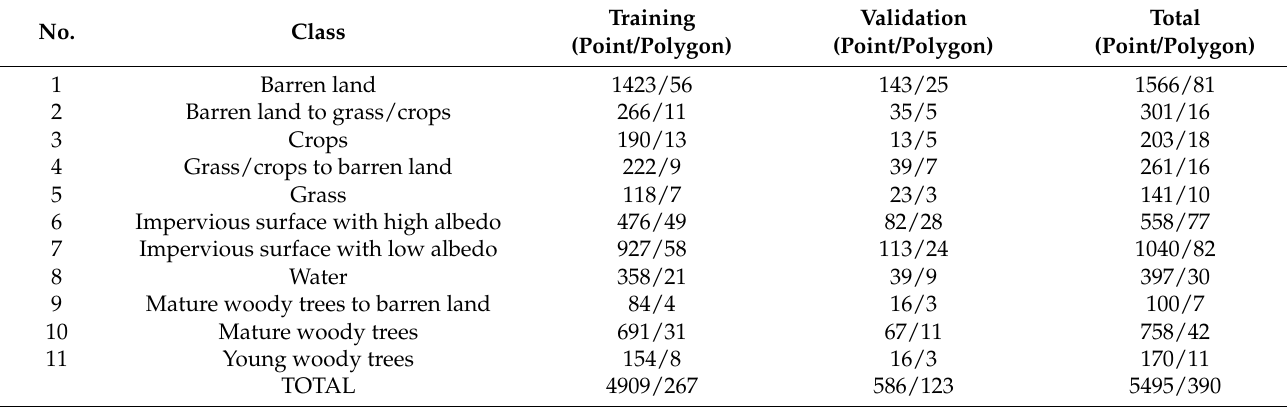
Table A1. Summary of training and validation data for the pre-land cover map.